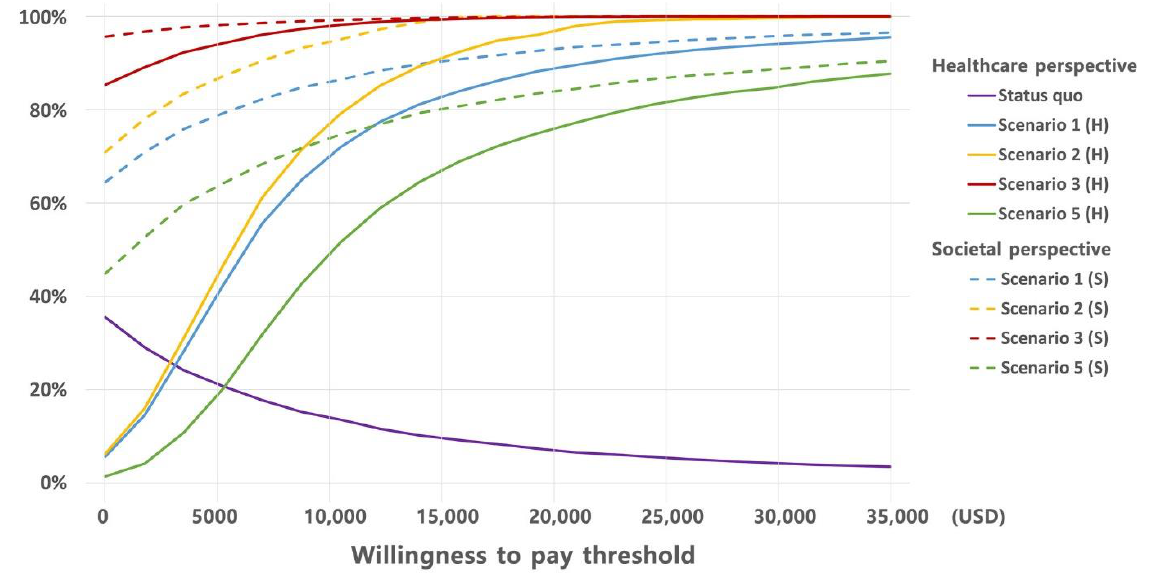
Figure 3. Cost-effectiveness acceptability curve by scenario: Scenario 1 (H) represents the base case from a healthcare sector perspective, Scenario 2 (H) represents 60% coverage for individuals aged 50–64 years from a healthcare sector perspective, Scenario 3 (H) includes only individuals aged 60–64 years in the policy from a healthcare sector perspective, Scenario 5 (H) has no indirect effects from a healthcare sector perspective, Scenario 1 (S) represents the base case from a societal perspective, Scenario 2 (S) represents 60% coverage for individuals aged 50–64 years from a societal perspective, Scenario 3 (S) includes only individuals aged 60–64 years in the policy from a societal perspective, Scenario 5 (S) has no indirect effects from a societal perspective. The threshold of willingness-to-pay is USD 30,681 per quality-adjusted life years.